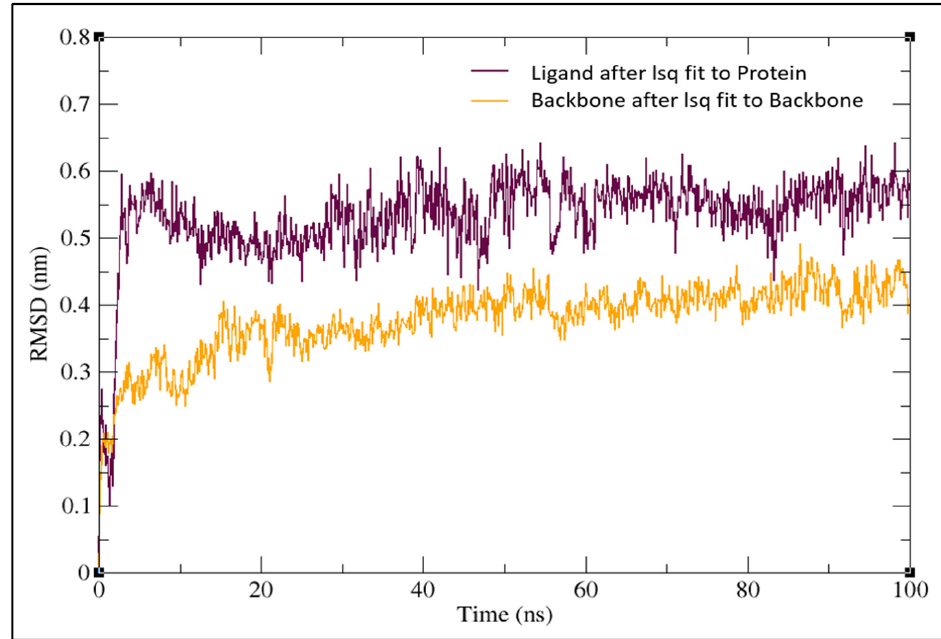
Figure 4. Molecular dynamics root mean square deviation (RMSD) plot for the docked complex of Pseudohypericin with COVID-19 main protease.